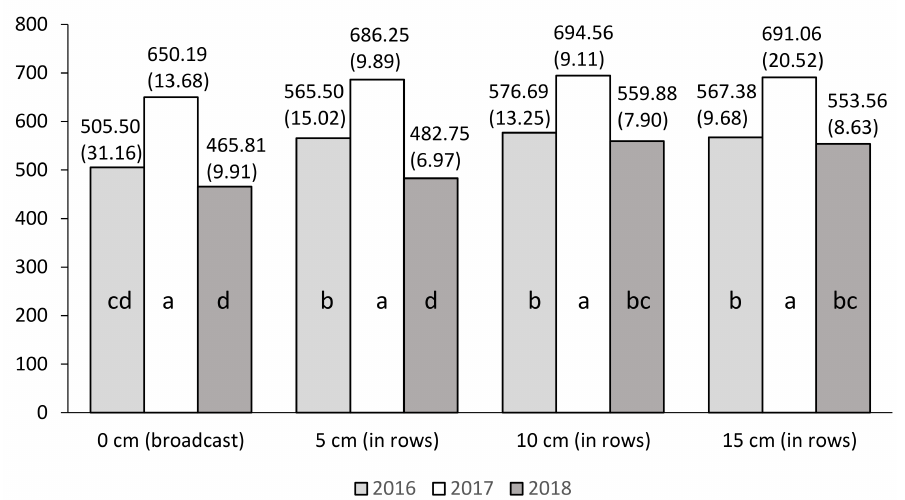
Figure 2. Mean values of index SPAD for the combinations of three years (Y) and four NP fertilizer sowing depths (A factor): BBCH 17/18. a, b, c, d: homogeneous groups ( p ≤ 0.05). Standard errors are in